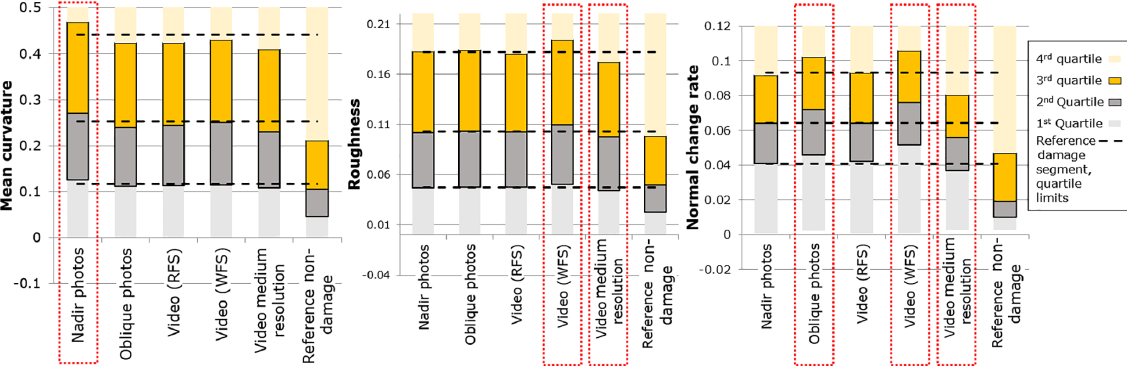
Figure 10. Tainan segment-level distributions of 3-D damage-related features. Dotted rectangles highlight discordant distributions from the reference damage segment and thus low depictability of 3-D damage-related